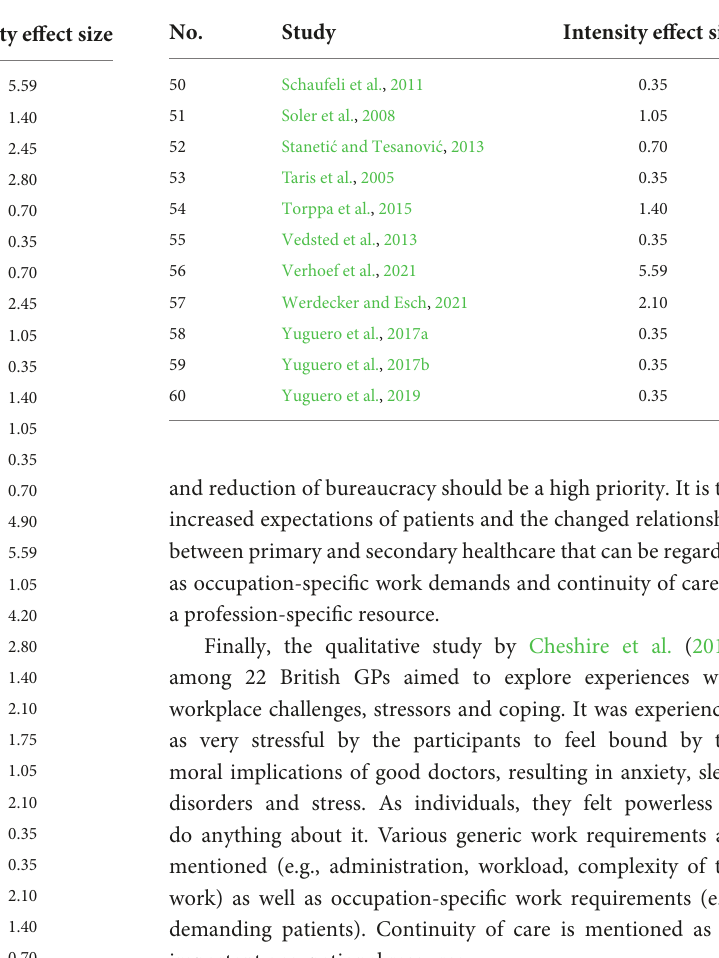
TABLE 8 Intensity effect size (IES) of all